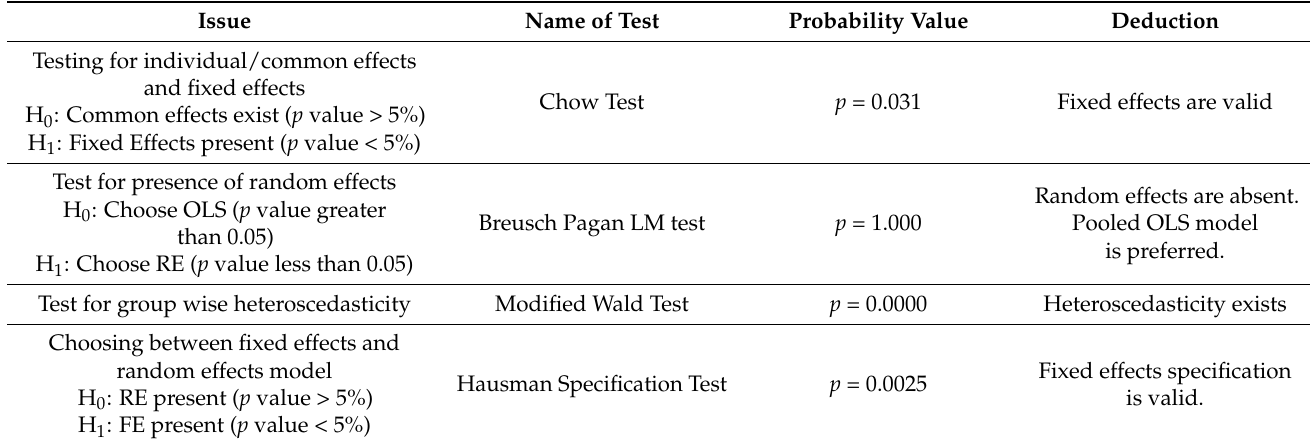
Table 5. Diagnostic Tests Using ROE as a Measure of Performance.